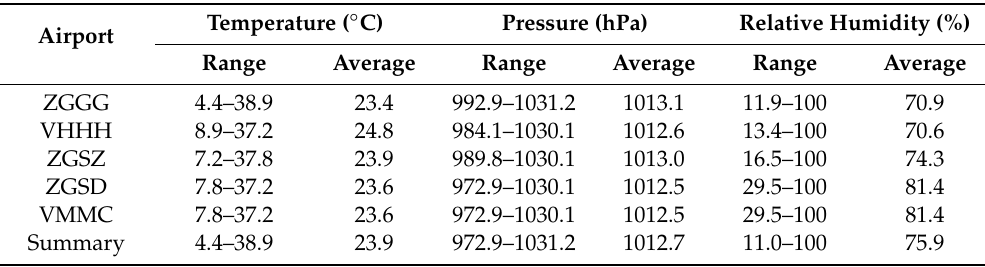
Table 1. The meteorological characteristics of the airports in the Guangdong–Hong Kong–Macao Greater Bay Area (GBA) in